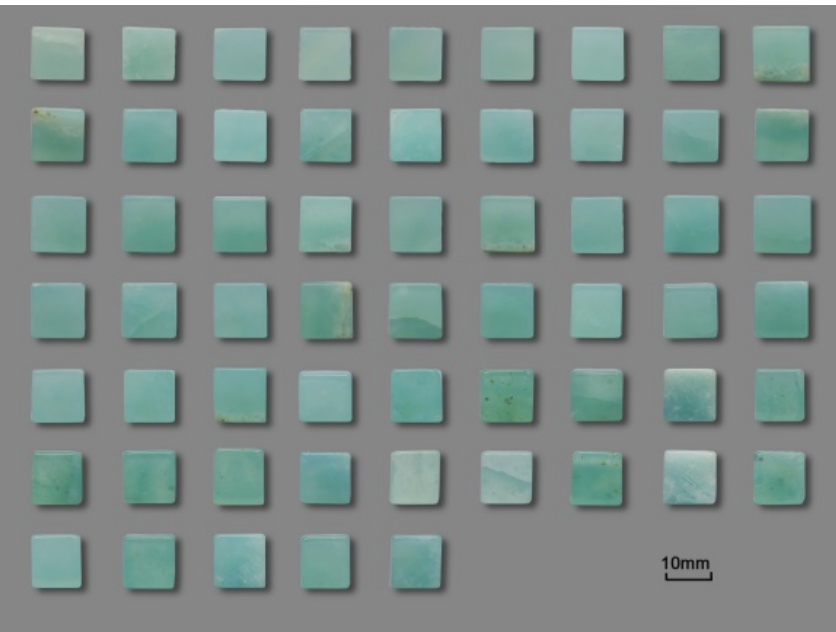
Figure 1. Photograph of 59 samples of bluish-green serpentinite. The main absorption peaks of the infrared spectra (FTIR) of the samples are 3674 cm − 1 , 1078 cm − 1 , 1050–960 cm − 1 , 632 cm − 1 , 563 cm − 1 , and 462 cm − 1 (Figure 4), which is the typical spectral of antigorite. It splits into two weak absorption peaks in the range of 1050–960 cm − 1 . Lizardite has a flat crystal structure, making the Si-O tetrahedron have pseudohexagonal symmetry. So, the two in-plane vibrations are degenerate, and there is only a broad band in the region of 1050–960 cm − 1 . Chrysotile forms a coiled layer with octahedron sheets outside and tetrahedron sheets inside. It splits into two obvious absorption peaks in this region because its symmetry is the lowest. Antigorite is composed of octahedral and tetrahedral sheets alternately and reversely, forming a wavy curved structure. Therefore, it only has two weak absorption peaks in this region [48]. The bending vibration of Mg-O at 563 cm − 1 shows a sharp peak in antigorite instead of a broad absorption band or a shoulder peak in chrysotile and lizardite [49].